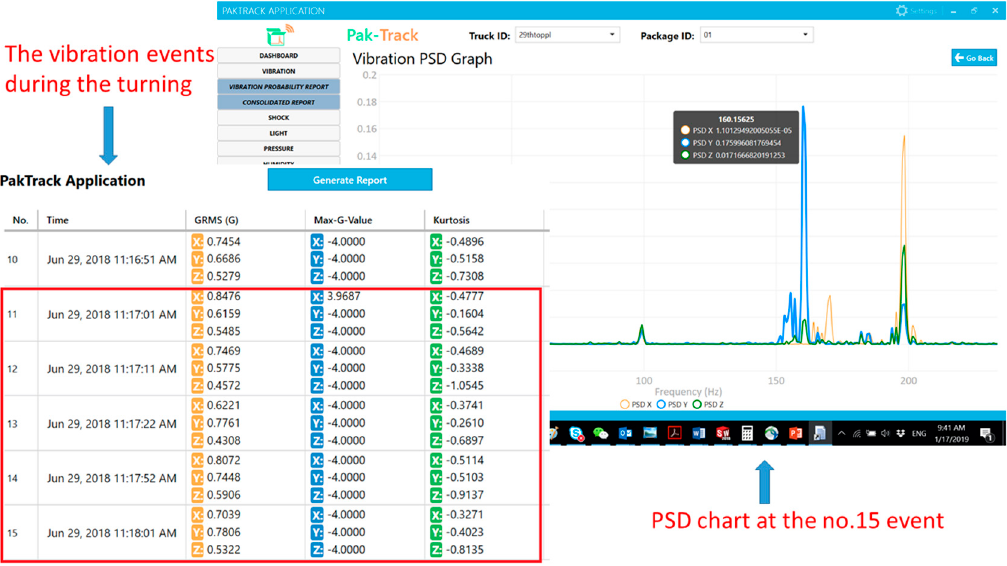
Figure 5. Exemplary vibration events during the turning of the drone.